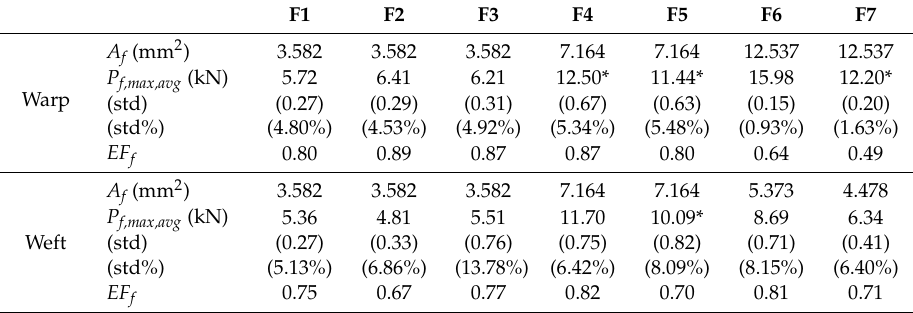
Table 5. Mechanical properties of the investigated fabrics: average maximum tensile loads and efficiency parameters (70 mm wide specimens).